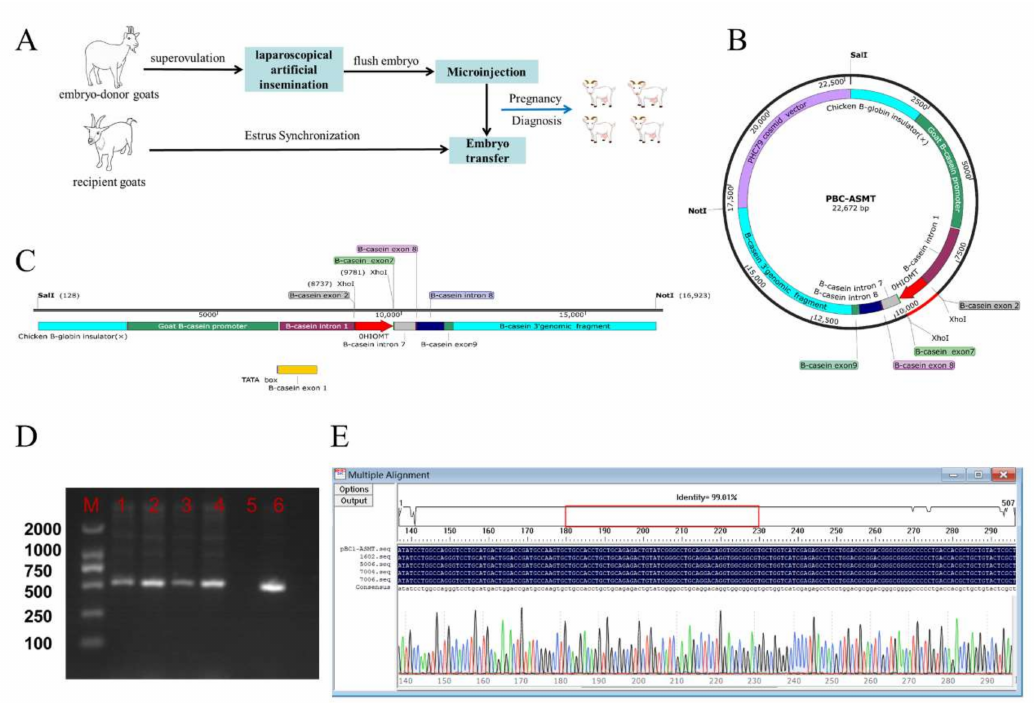
Figure 1. The procedure to generate ASMT -overexpressed goats. ( A )The process used to design prokaryotic embryo microinjection; ( B ) pBC1-ASMT vector; ( C ) micro-injection vector of ASMT; ( D ) PCR identification of transgenic offspring (M: marker, 1:1602, 2:5006, 3:7004, 4:7006, 5: control, 6: pBC1-ASMT); ( E ) sequence alignment of transgenic offspring.